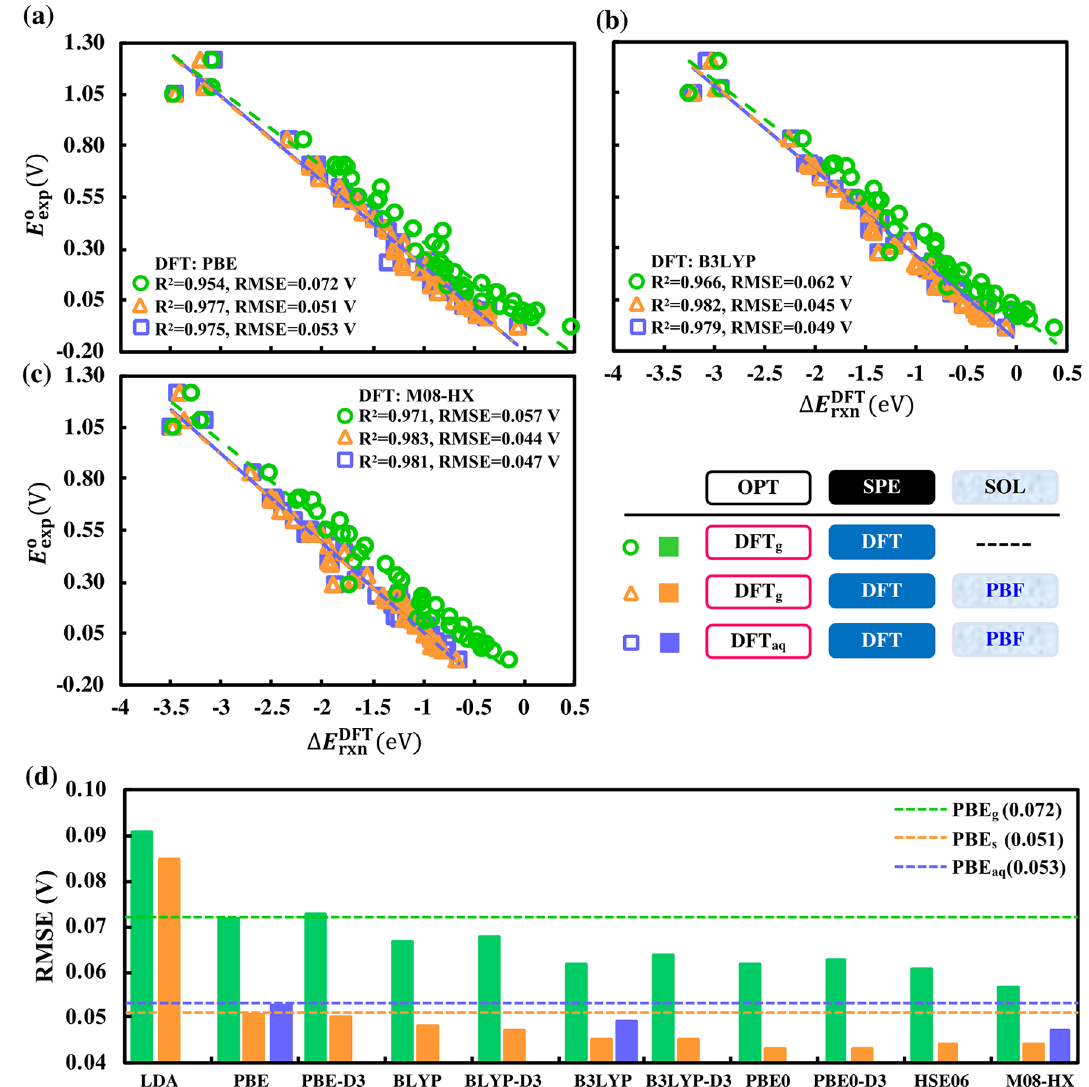
Figure 2. Performance comparisons of different exchange–correlation functionals in predicting the experimentally measured redox potentials, E o exp . The scatter plots ( a – c ) show linear correlations of the DFT calculated energy difference, (cid:31) E DFT rxn , versus E o exp , for the three representative functionals of ( a ) PBE, ( b ) B3LYP, and ( c ) M08-HX. The bar plot ( d ) shows the RMSE for all the functionals considered. The color green represents both OPT and SPE in gas-phase, the color orange represents OPT in gas-phase followed by SPE with SOL, and the color blue represents both OPT and SPE with SOL, as also summarized in a tabular format. In ( d ), the horizontal dashed green line represents PBE g (RMSE = 0.072 V, R 2 = 0.954) benchmark, the horizontal dashed blue line represents PBE aq (RMSE = 0.053 V, R 2 = 0.975) benchmark, and the horizontal dashed orange line represents PBE s (RMSE = 0.051 V, R 2 = 0.977)